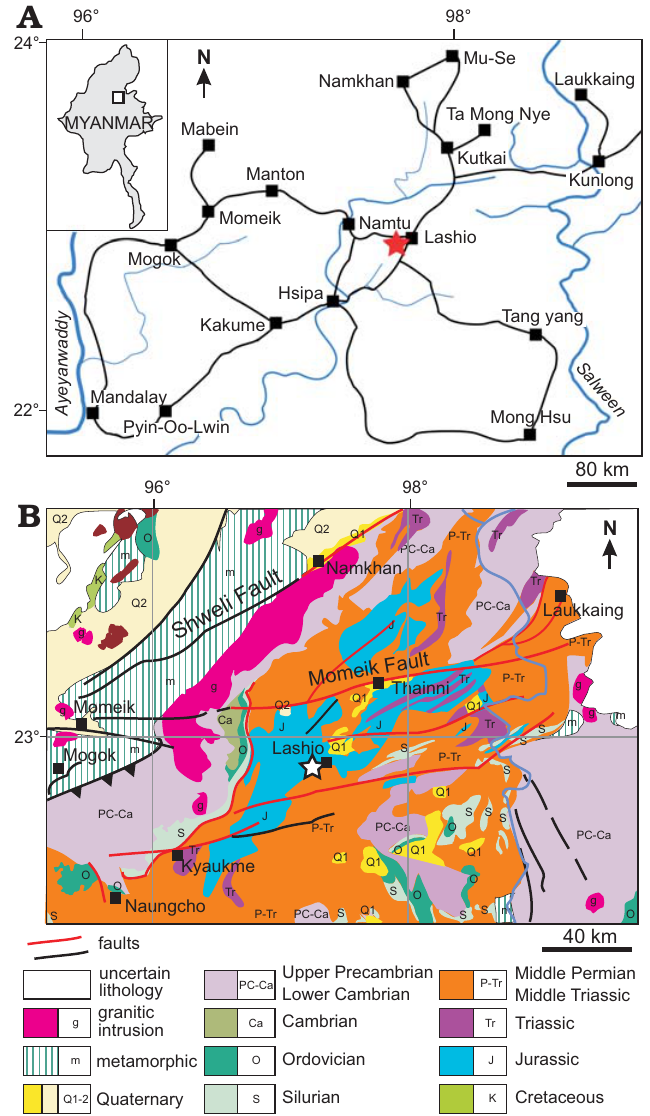
Fig 1. Geographical ( A ) and geological setting ( B ) for the Triassic pachy- pleurosaurs from Myanmar. Study area indicated by a star. B based on the 2014 geological map of Myanmar from the Myanmar Geoscience Society.